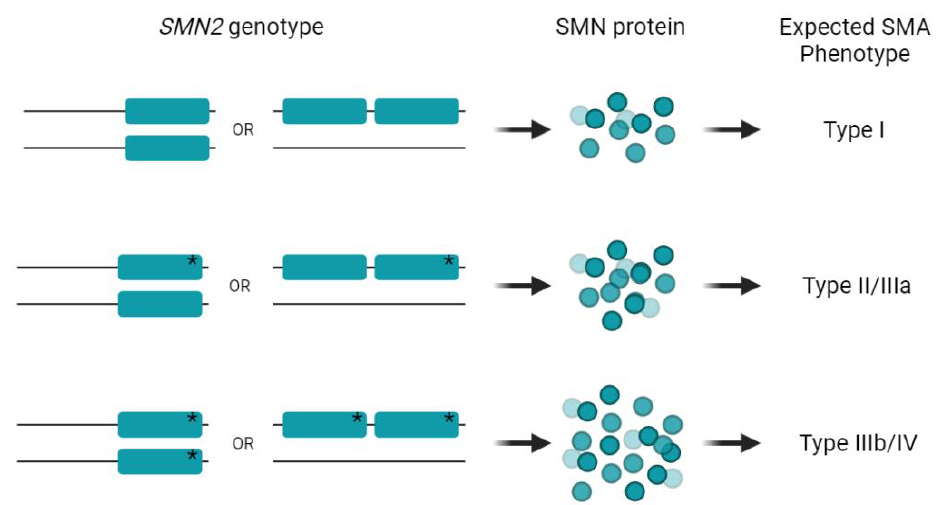
Figure 2. Expected SMA phenotype in cases with two SMN2 copies according to the presence of c.859G>C. An additive effect on SMA phenotype is observed depending on whether the c.859G>C variant is found in one or both SMN2 copies. SMN2 gene is represented as a rectangle, and the presence of the c.859G>C variant in exon 7 is indicated by an asterisk. Not all SMN2 genotypes represented in this figure were detected in this study (see Figure 1 for more details).